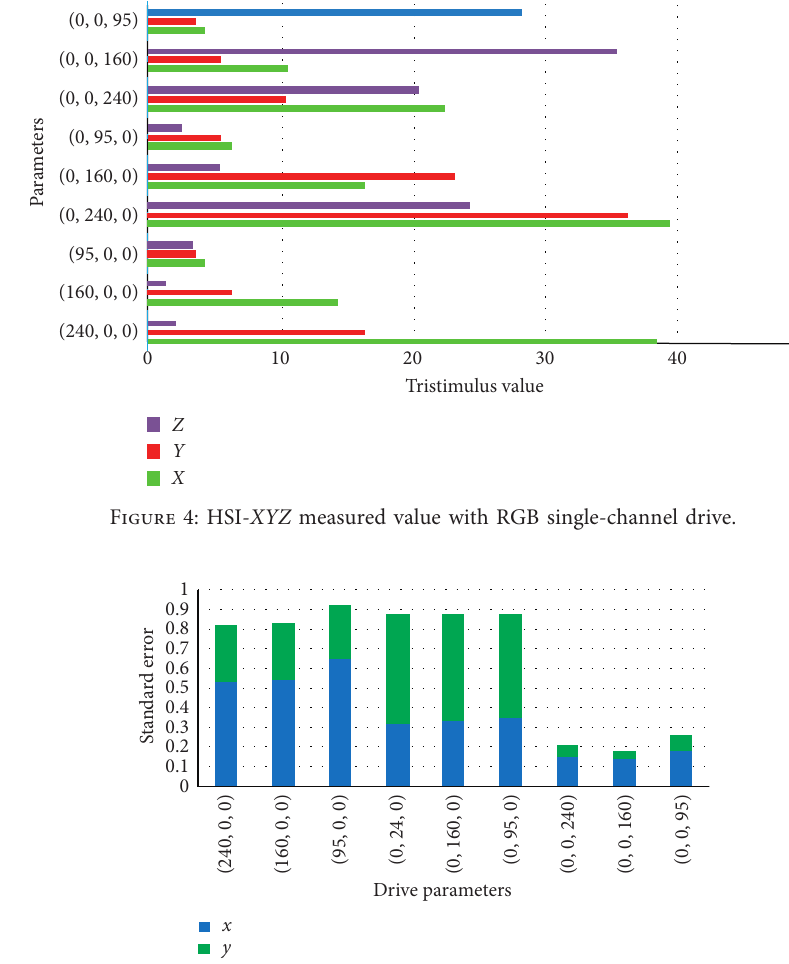
Figure 5: XY standard error with RGB single-channel drive.